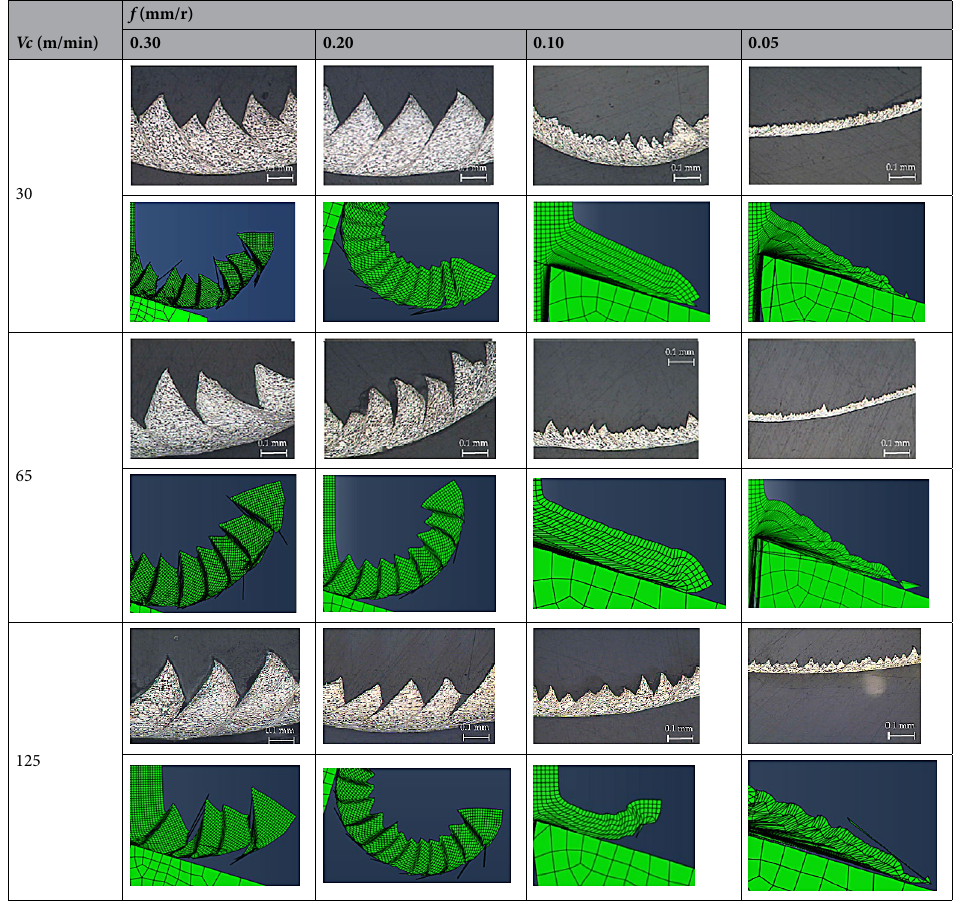
Table 10. Chip geometry comparative between experimental tests and FEM